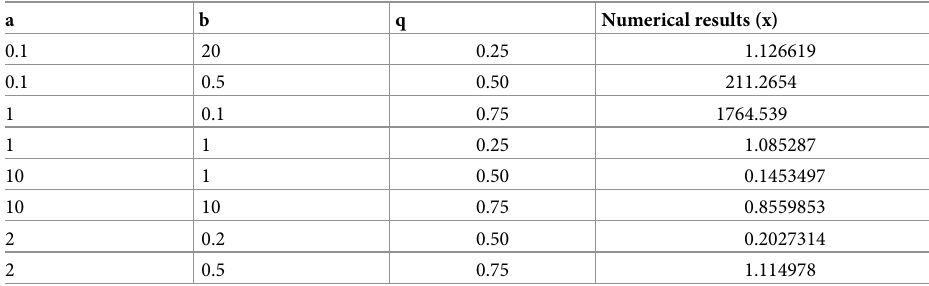
Table 1. Numerical results with different values of parameter and